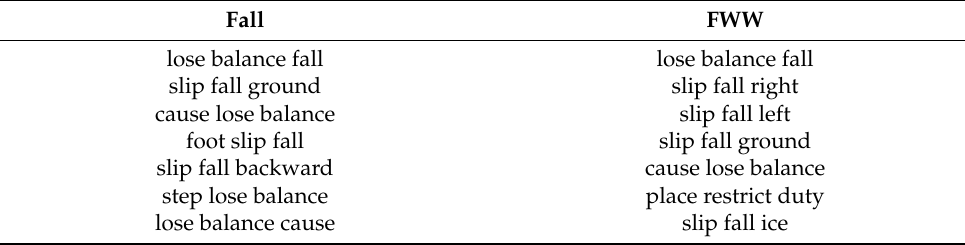
Table 5. Results of trigram analysis on Fall accident